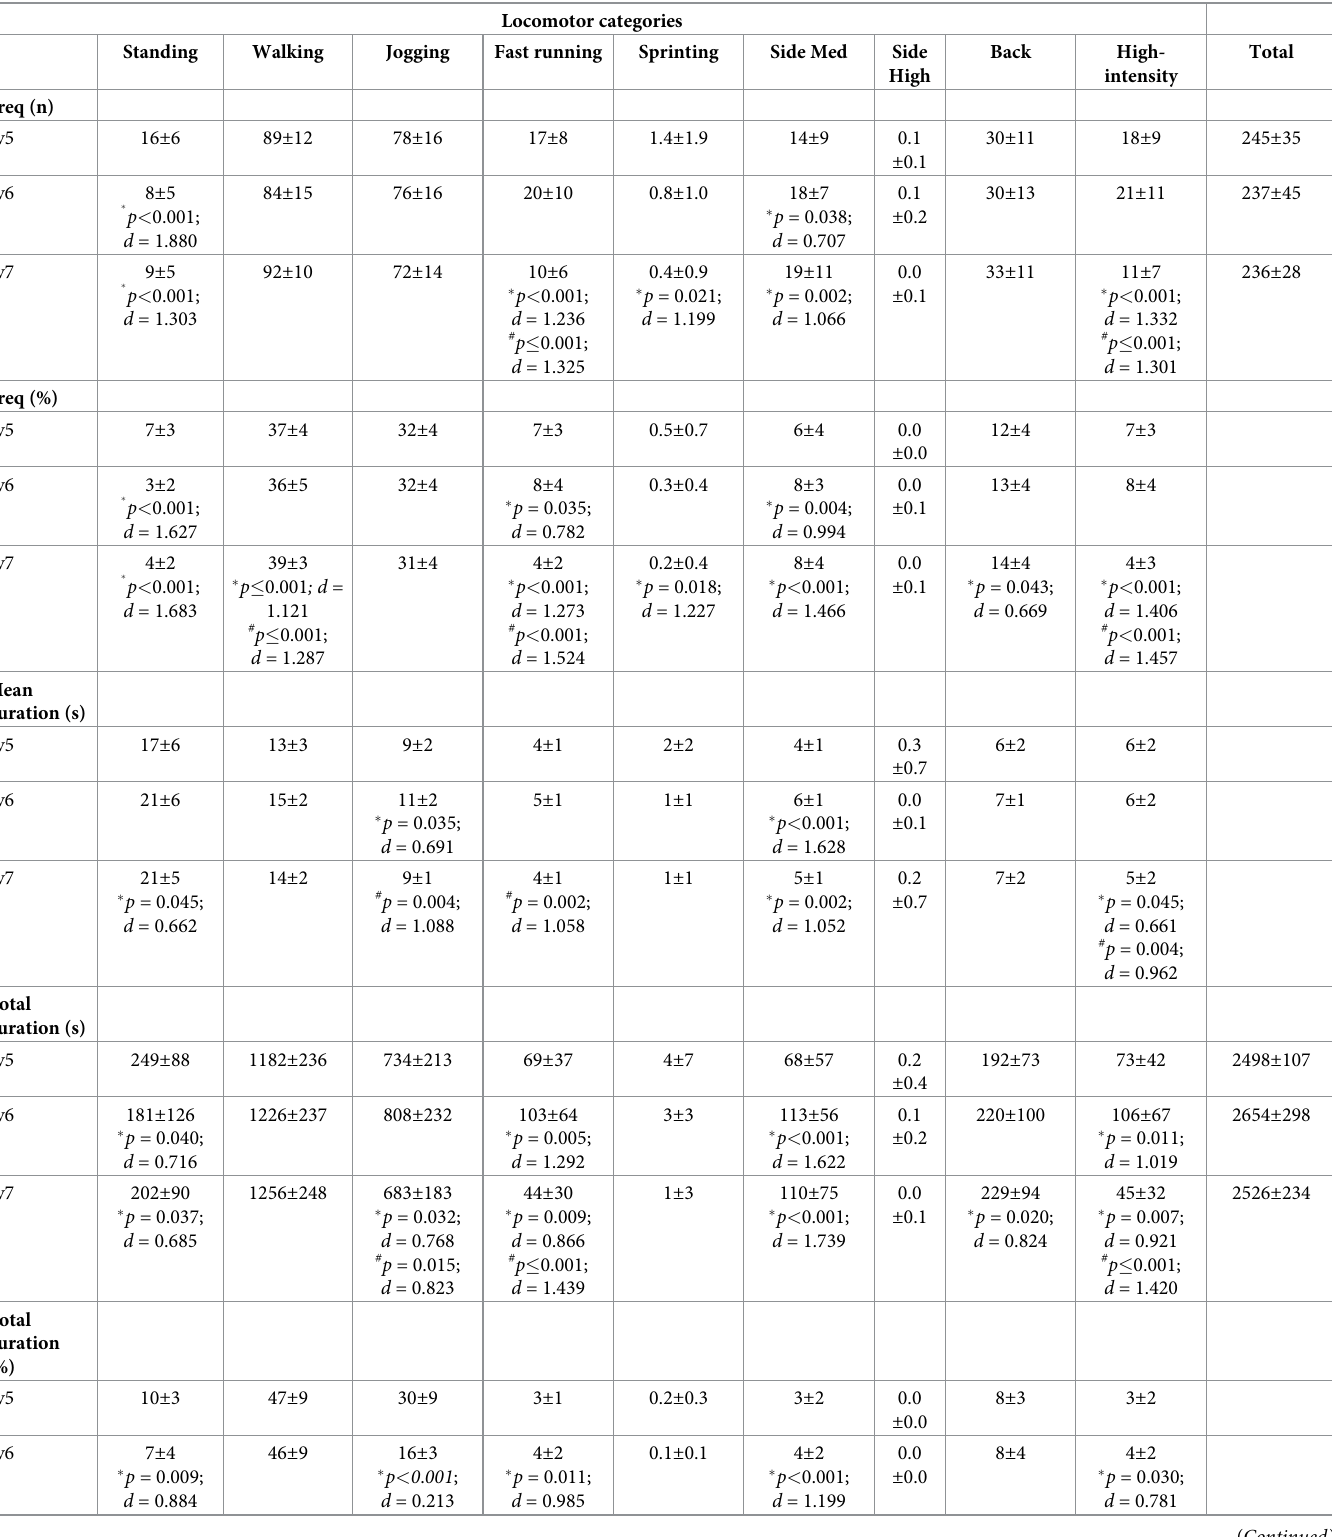
Table 2. Players’ locomotor profile during recreational team handball game formats (5v5, 6v6 and 7v7) (data are presented as means ± SD). Locomotor